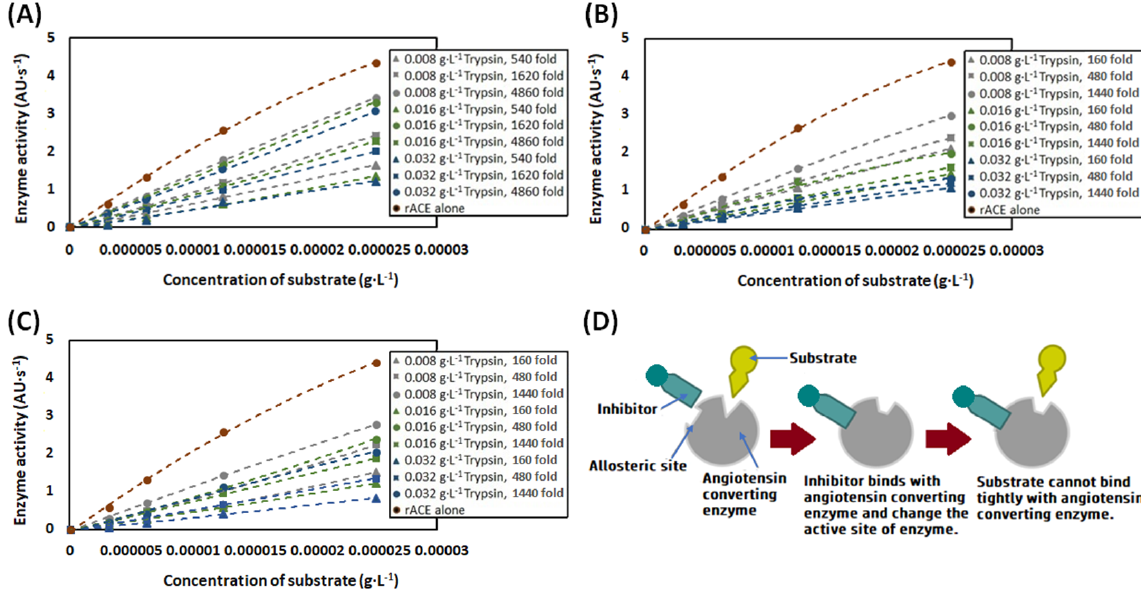
Figure 10. Activity of the angiotensin-converting enzyme in the presence of different concentrations of protein hydrolysate, prepared by the tryptic hydrolysis of LMPC ( A ), LMPC-T-F and ( B ) and LMPC-T-F G ( C ). Mechanism of the inhibition of the angiotensin-converting enzyme ( D ) (self-developed graphic; the concept was adopted from Guang and Phillips, 2009 [104] and Vallabha and Kaultiku, 2006 [105]).